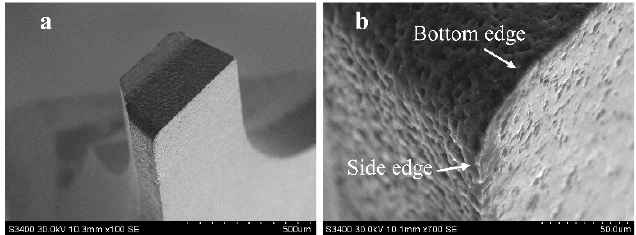
Figure 2. Polycrystalline diamond (PCD) micro end mill. ( a ) Overview of the tool geometry; ( b ) enlarged view of the tool tip.